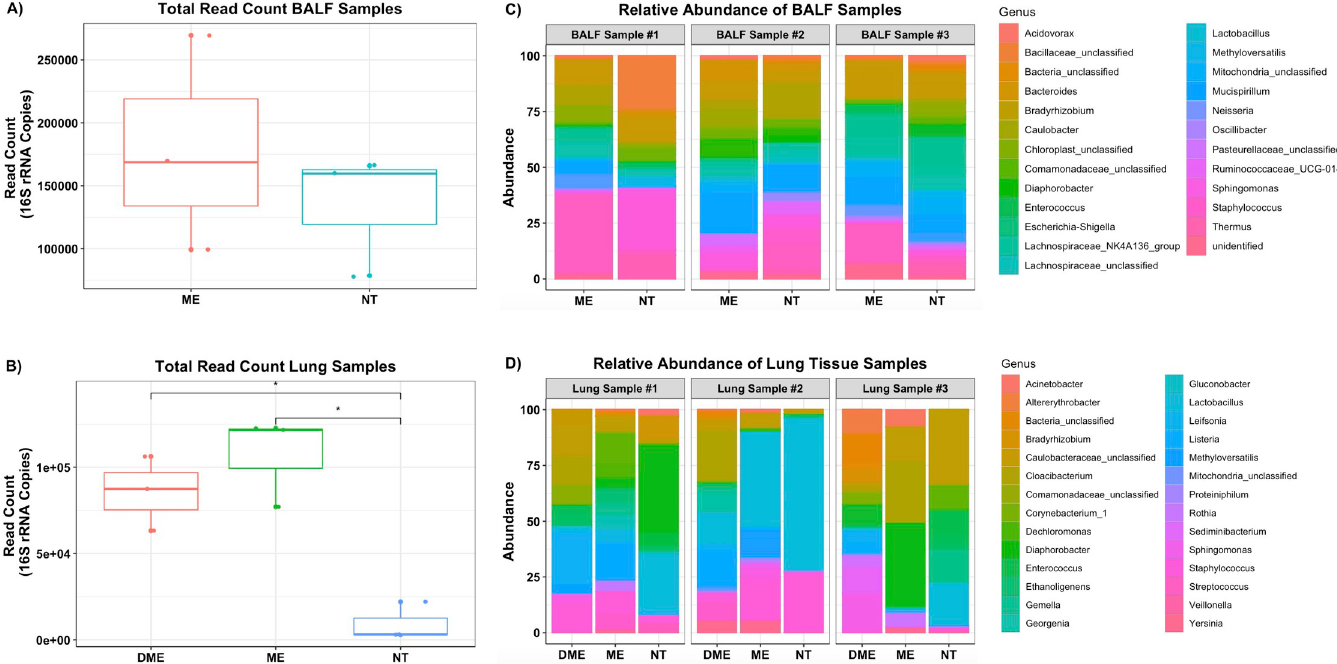
Fig 5. Comparing the efficiency before and after treatment with the NEBNext microbiome DNA Enrichment Kit. A) No significant improvements observed when comparing microbiome enriched (ME) and non-treated (NT) BALF samples total read count. B) However, significant improvements observed when comparing DME (1:10 diluted sample then treated with ME kit), ME, and NT lung samples total read count. Significance (p-value) between groups is indicated by stars ( � < 0.05 and �� < 0.01). Both C) BALF and D) lung samples showed difference in community composition (genus level) between NT and ME samples, particularly diluted lung samples treated with microbiome enrichment